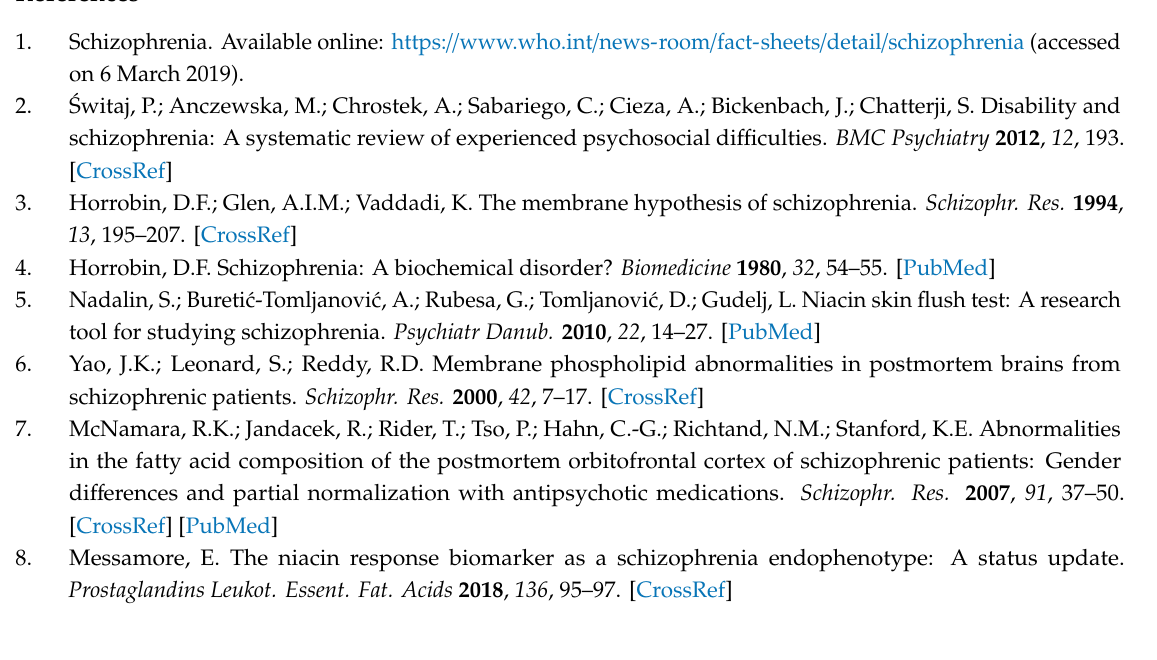
Table S1: Di ff erences in response to niacin solution between examined